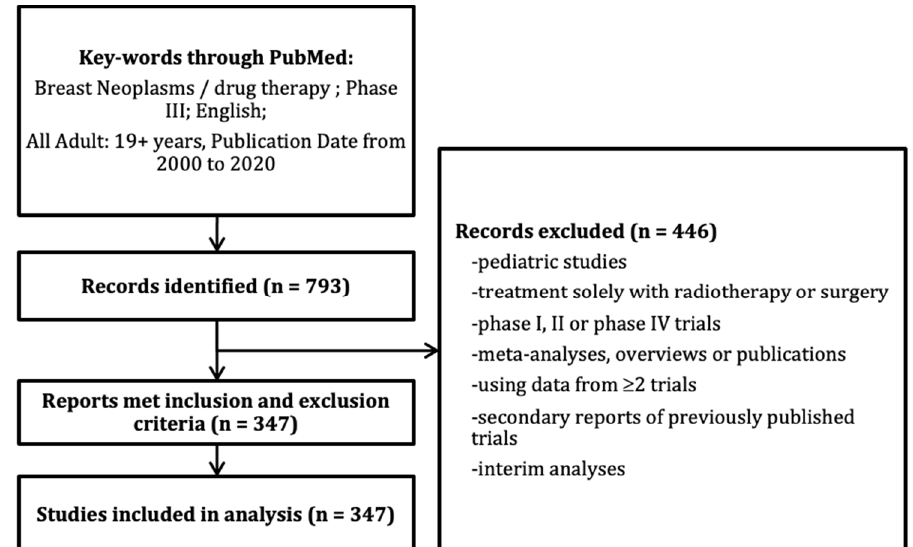
Figure 1. Selection of randomized clinical trials in the systematic review.